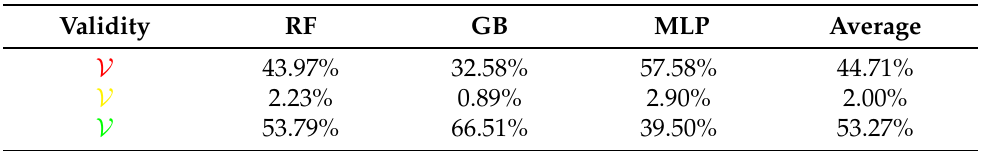
Table 12. Experiment 2: rate of validity of RHOASo Vs HPO across all D i (% with MCC and time